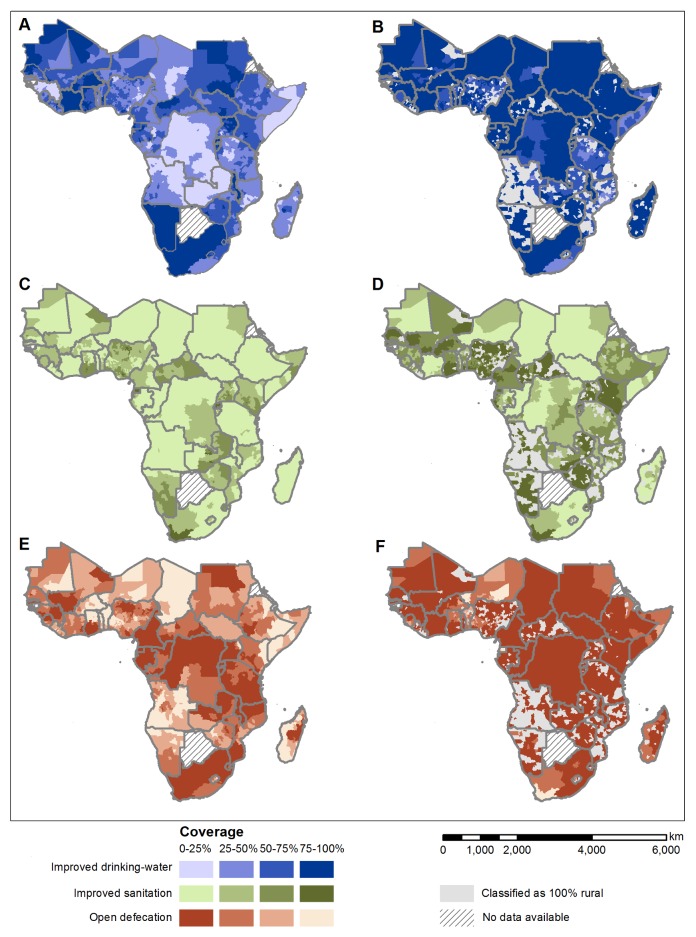
Predicted population coverage in 2012 for rural and urban populations, by second administrative area.Access to improved drinking-water supply in (A) rural and (B) urban populations; access to improved sanitation in (C) rural and (D) urban populations; and open defecation in (E) rural and (F) urban populations. Model results showing posterior median predicted coverage (i.e. most likely value) for each second administrative area. No data was available for Botswana and Eritrea (hatched). Each indicator was modelled independently.